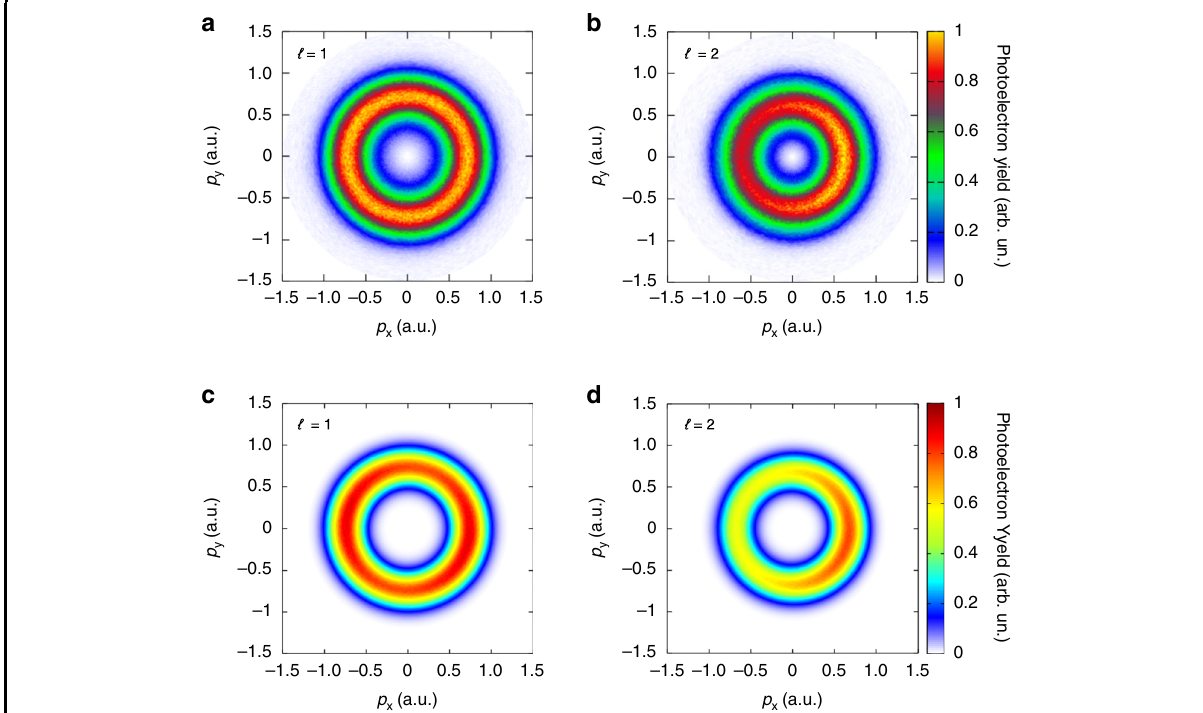
Fig. 4 Probing the OAM of intense vortex pulses with the spatially sculpted light fi eld. a , b Measured photoelectron momentum distributions. c , d Simulated photoelectron momentum distributions. The topological charges of 400-nm fi elds are ( a , c ) ℓ = 1 and ( b , d ) ℓ = 2,